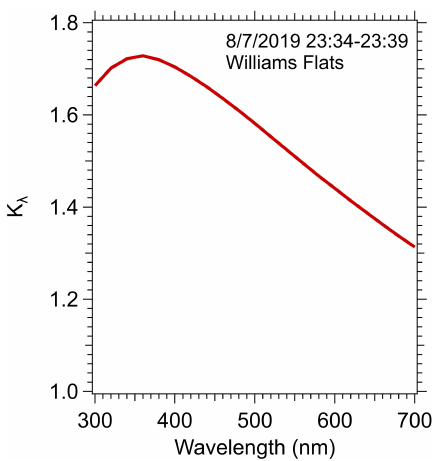
Figure 4. Solution-to-particle light-absorption conversion factor K λ versus wavelength calculated from Mie theory for data collected in the first transect of the Williams Flats fire during 23:34–23:39 7 August 2019